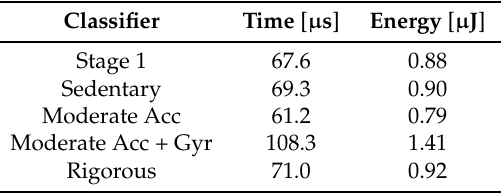
Table 10. Classifier computation